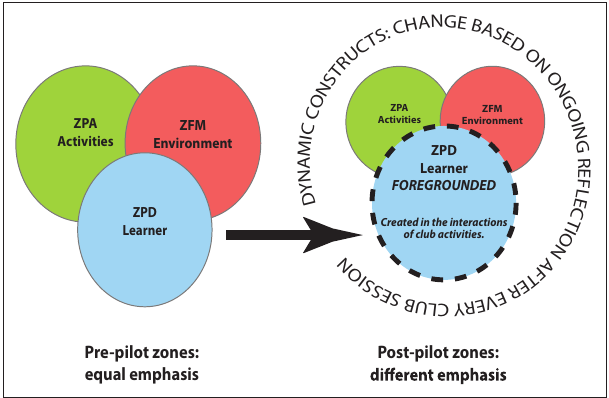
FIGURE 4: Change of emphasis in the zones pre-pilot and